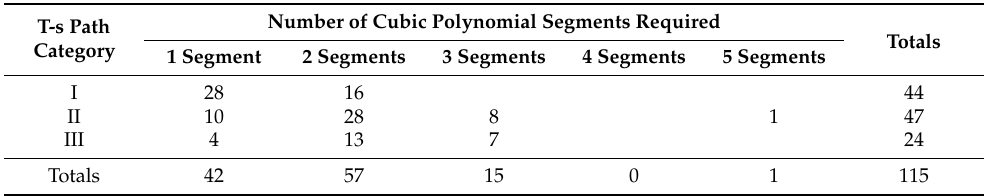
Table A4. Cubic polynomial solution segments required versus polytropic path curve category for 115 example cases.